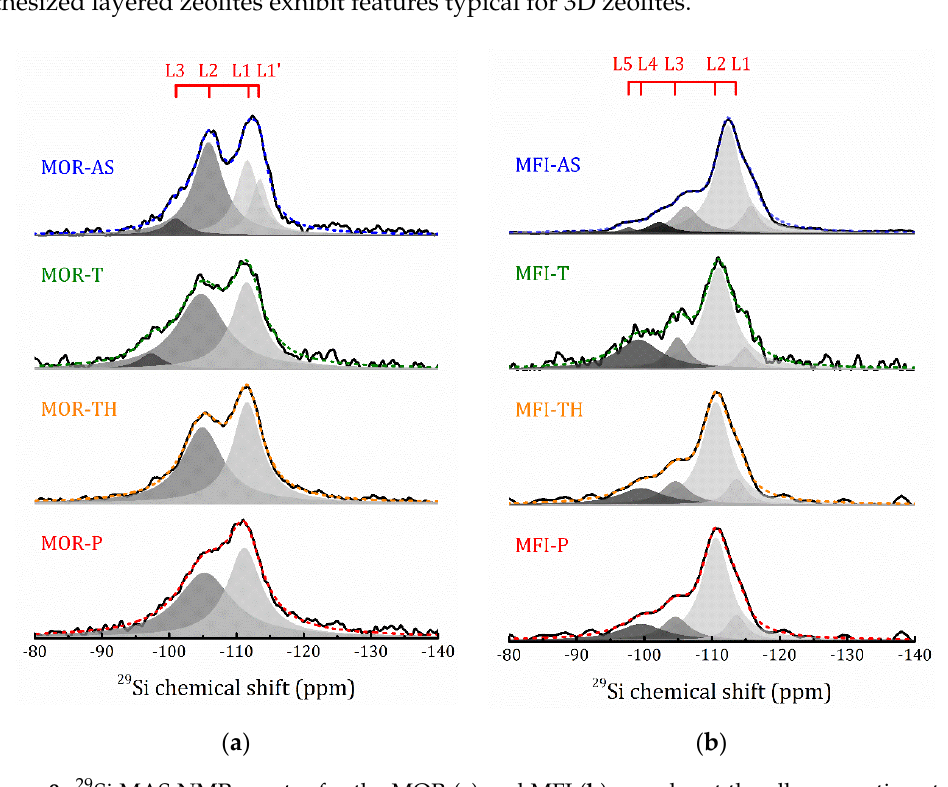
Figure 9. 29 Si MAS NMR spectra for the MOR ( a ) and MFI ( b ) samples at the all preparation steps. Filled patterns represent decomposition on Lorentzian functions, dashed lines represent the total fit.